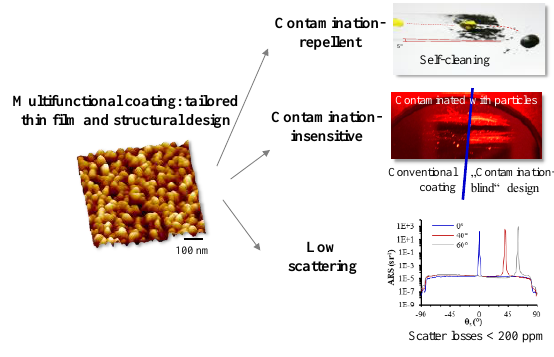
Fig. 1. Multifunctional contamination-resistant coating